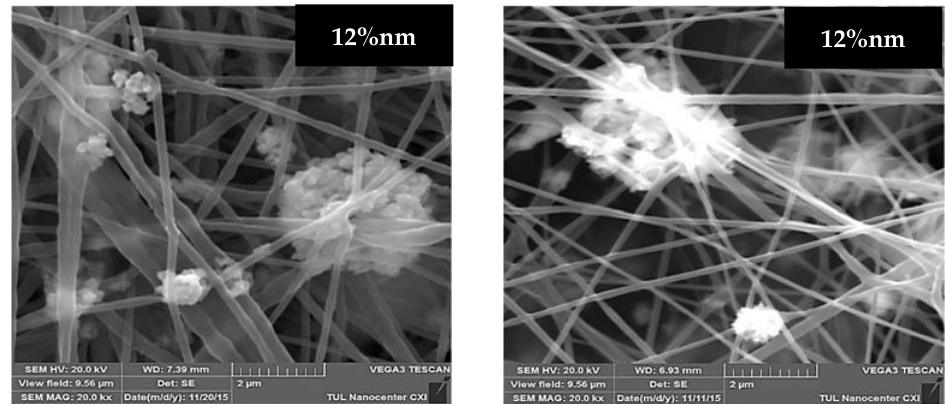
Figure 4. SEM images (20,000 × magnification) of composite nanofibers produced from both elec- trodes with different concentrations of nanoparticles of CuO.